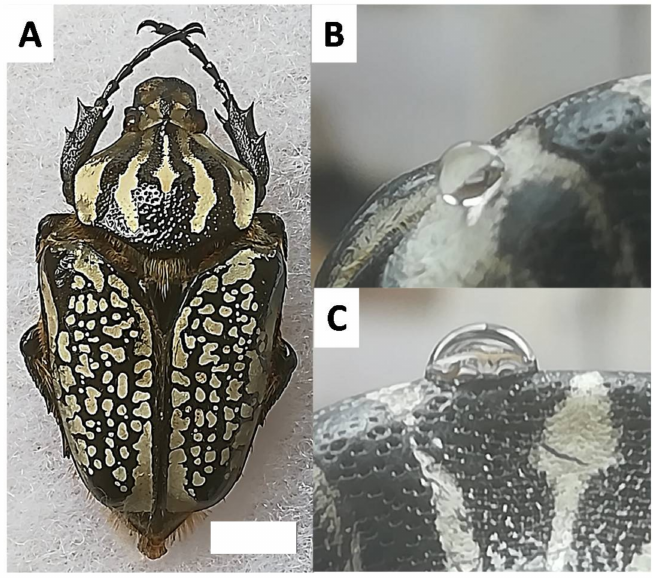
Figure 1. ( A ) Specimen of Goliathus orientalis (Moser, 1909); scale bar: 1 cm. ( B ) Water droplet deposited on the white part of the G. orientalis pronotum. ( C ) Water droplet deposited on the black part of the G. orientalis